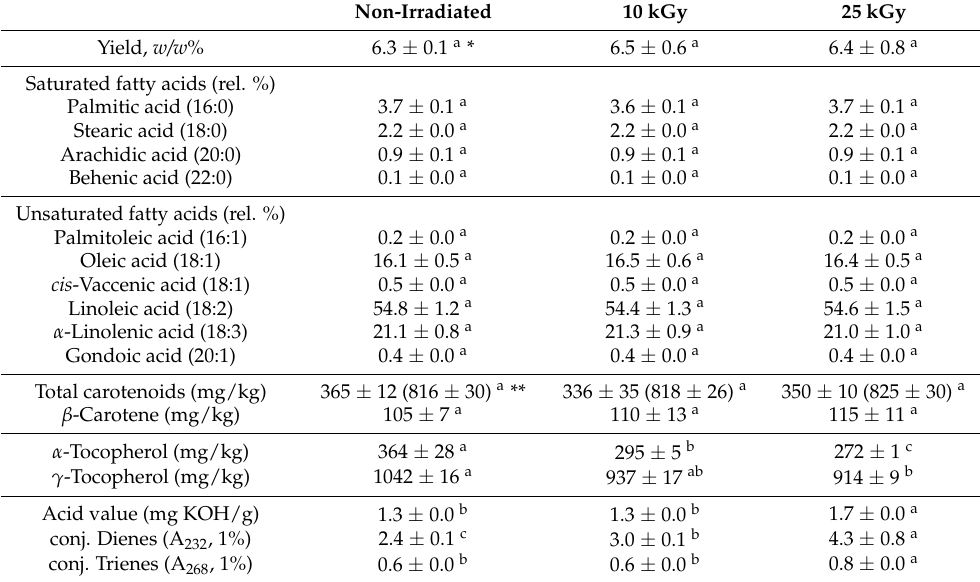
Table 2. Yield and lipid composition of seed oil extracted from non-irradiated, 10 kGy-, and 25 kGy-irradiated RH fruits.